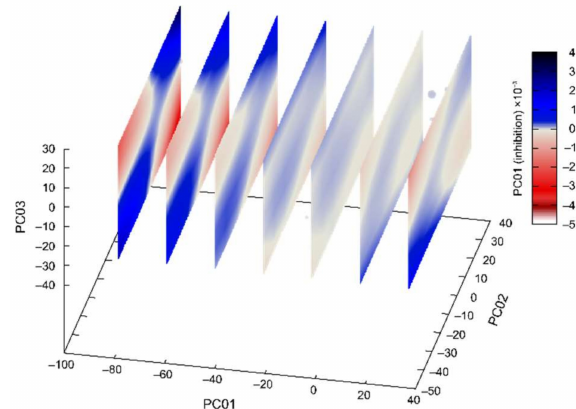
Figure 5. Machine learning determined the best multivariate regression model for fluorinated CN - derivatives inhibition of AChE and BChE in dependence on the first three principal components of compounds’ potential energy surfaces. (Spheres represent points in 3D reduced space, and the planes are cuts of the calculated polynomial regression model, for easier interpretation 4th-dimension is represented redundantly with the color and with the size of the